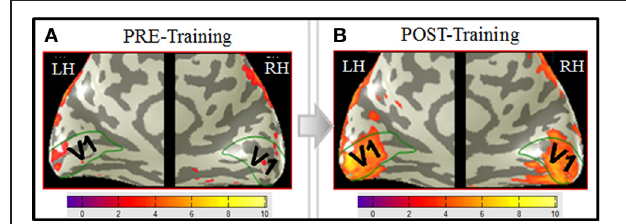
brain optimally visualize area V1 (green outlines) along the calcarine sulcus. Scale bars show the color-coding for the z -score levels of the activation. Comparison of the pre- to post -training responses shows a dramatic enhancement from negligible activation in V1 before training (A) , to a massive task-specific activation as a result of training (B) . Note that, interestingly, the extension of the post-training activation approximately corresponds to the spatial extent of the images ( ∼ 10 ◦